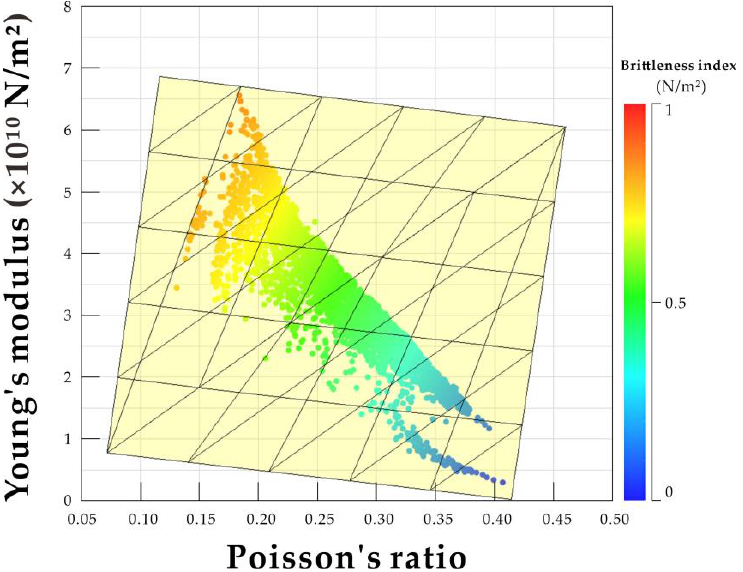
Figure 7. Cross plot of Poisson’s ratio and Young’s